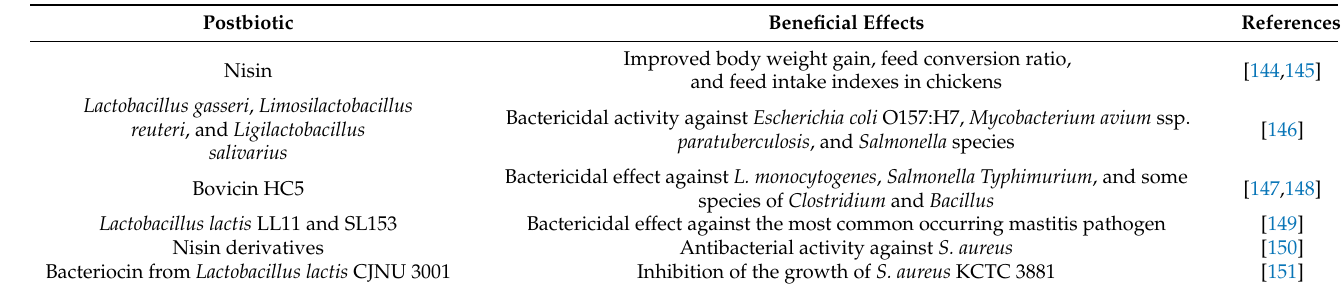
Table 2. Overview of the application of postbiotics and their beneficial effects in bovine